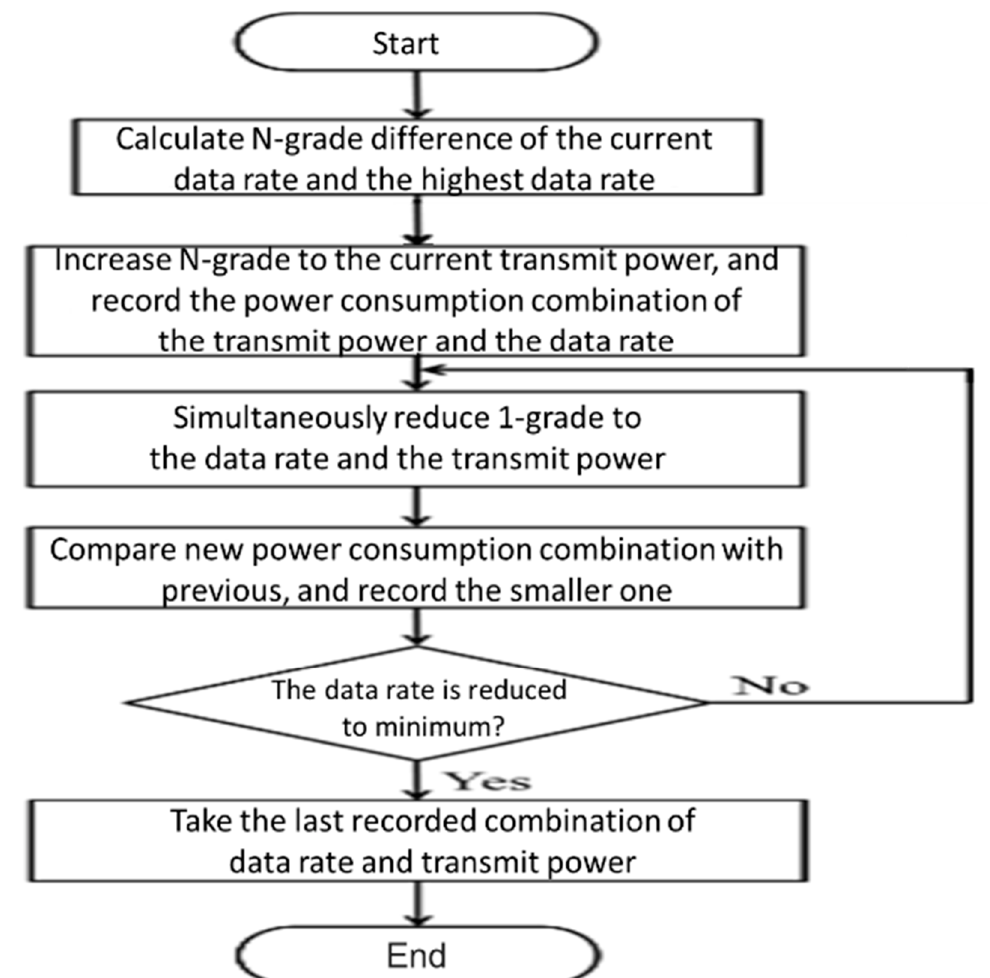
Figure 12. Flowchart for selecting the best energy efficient combination of data rate and transmit power.